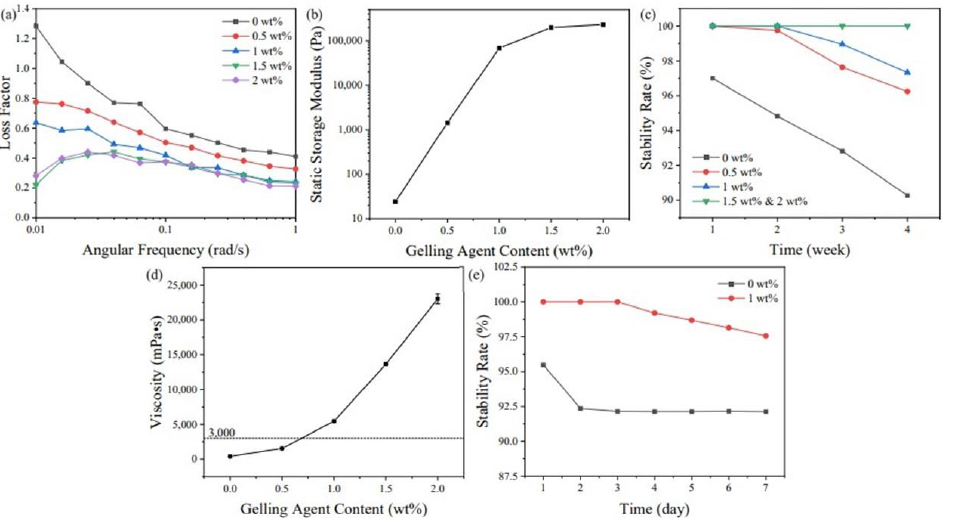
Figure 9. ( a ) The relationship of angular frequency and loss factor under various gelling agent content, and the effects of gelling agent content on ( b ) static storage modulus, ( c ) stability rate, ( d ) viscosity of ZF10 slurries, and ( e ) stability rate of 200-mesh slurries.